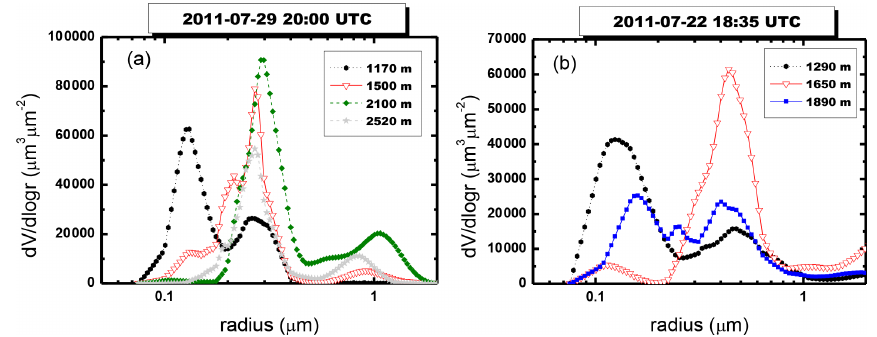
Figure 9. Particle volume size distributions at different levels obtained from the stand-alone 3 β + 2 α lidar inversion for (a) 29 July 2011 and (b) 22 July 2001.